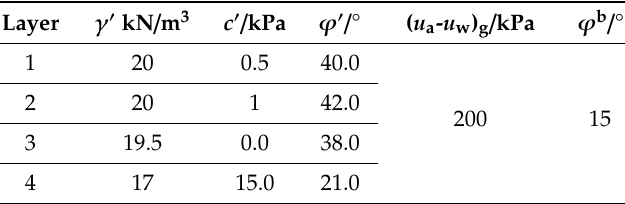
Figure 9. The geological profile of a high road fill. Table 2. Physic-mechanical properties of